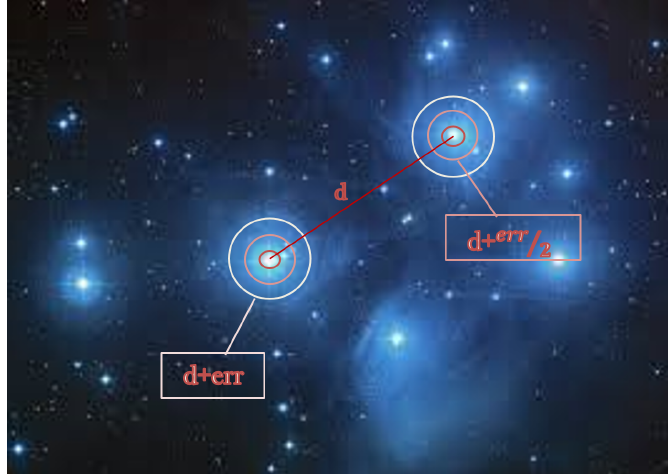
Figure 4. A graphic representation of Gauss’s distribution of standard distance deviation err around the stars.